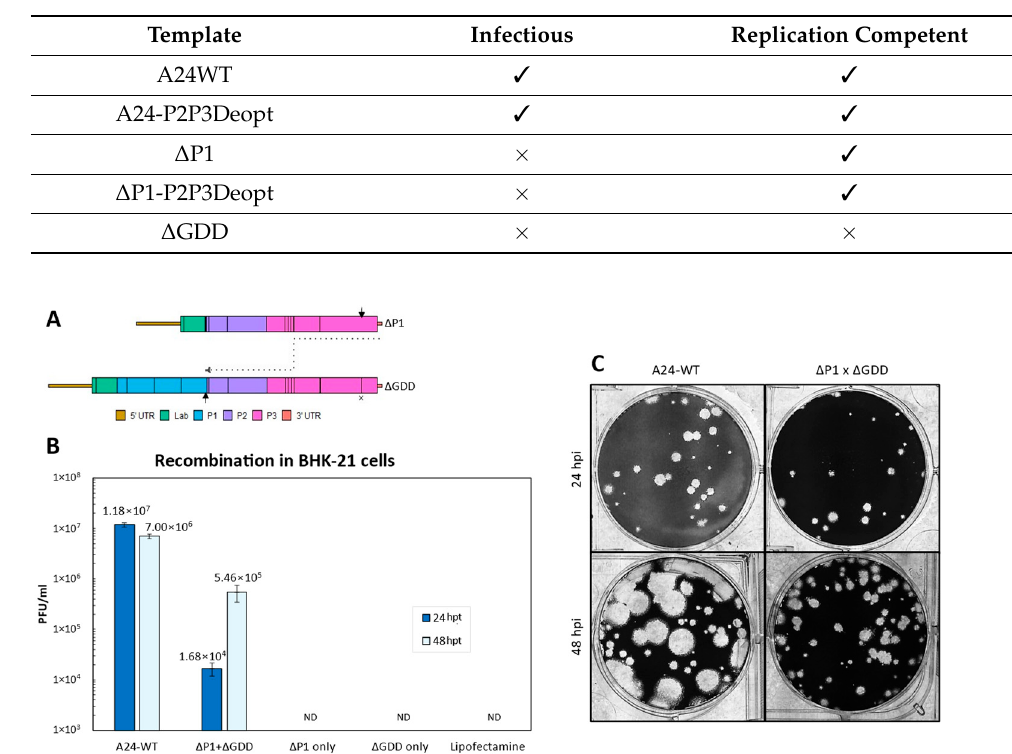
Figure 1. Schematic diagram of the FMDV RNA templates used during transfection. DIVA markers are indicated by open (3B1 deletion, RQKP9-12 → PVKV) and closed (3D H27N31 → YR) triangles. Deoptimized regions are indicated by stripes. Δ GDD within the active site of RdRp encoded by 3D is indicated by an X. Table 1. Genotypic and phenotypic characteristics of viral RNAs.